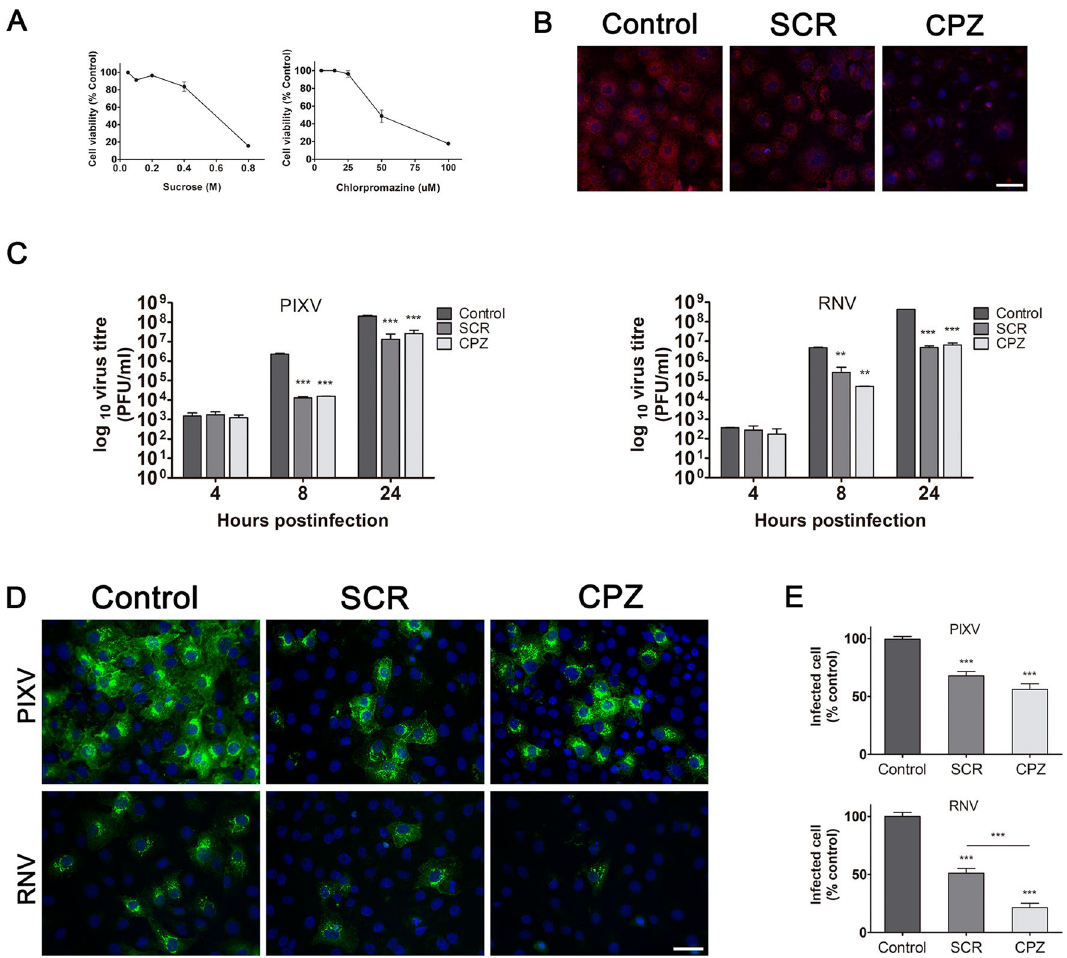
Figure 1. Assays with inhibitors targeting clathrin-mediated endocytosis of PIXV and RNV entry. ( A ) MTT assay to determine SCR and CPZ cytotoxic concentrations. ( B ) Representative images of Vero cells treated with 0.2 M SCR or 25 µM CPZ and incubated with TRITC-transferrin (red); nuclei (blue). ( C ) Cells were treated with 0.2 M SCR or 25 µM CPZ and infected with PIXV or RNV at MOI 0.1. Supernatants were collected at 4, 8 and 24 hpi and extracellular infectious particles were quantified by plaque assay (plaque-forming unit, PFU/ ml). ( D ) Representative images of cultures treated with 0.2 M SCR or 25 µM CPZ and infected with PIXV or RNV (green) at MOI 10 and fixed at 8 hpi; nuclei (blue). ( E ) Percentage of infected cells with PIXV or RNV against control (100% value). Data represent the mean ± SD from 3 independent experiments. Significance was calculated by one-way ANOVA test, followed by Tukey post-hoc analysis to enable specific group comparisons, with p value ≤ 0.05 considered as statistically significant. ** p < 0.01; *** p < 0.001. Scale bar: 20 ments and the viral proteins (PIXV: r = 0.68 ± 0.11 for Rab5 and r = 0.78 ± 0.06 for Rab7; RNV: r = 0.69 ± 0.1 for Rab5 and r = 0.75 ± 0.07 for Rab7) (Fig. 3B). These results show that PIXV and RNV associate to early and late endosomes at the early stage of the infectious cycle. To study the low pH-dependence of PIXV and RNV replication, we first evaluated the effect of two lysoso- motropic agents, GlcN and NH 4 Cl, inhibitors of endosomal vesicles acidification 10,26–33 , in Vero cells. Cell culture viability by MTT was assayed at different concentrations of either of these two inhibitors (Fig. 4A). Thus, we defined 15 mM GlcN and 25 mM NH 4 Cl as the experimental conditions (cell viability ≥ 90%). To assure the effect of both compounds in intracellular acidic vesicles, we pretreated Vero cells with the drugs plus acridine orange. Cultures treated with NH 4 Cl showed significant differences in the fluorescence intensity of the cells cytoplasm (56.3%; p < 0.001) compared to controls (100%). However, this effect was not observed in culture cells treated with GlcN, where acridine orange fluorescence inside the cell cytoplasm did not display significant differences (87.1%) compared to the control condition (Fig. 4B). We then performed the cytoplasmic accumulation assay with neutral red, a very sensitive probe for lysosomal microenvironments and a biological pH indicator 43 . In Fig. 4C, a 40% and 80% inhibition of the neutral red signal can be observed in cultures treated with GlcN and NH 4 Cl, respectively, compared to untreated cells. Therefore, the participation of endosomal pH in PIXV and RNV replication in Vero cells was analyzed by extracellular virus titration. Viral progeny production of PIXV and RNV was reduced by about 3 log 10 and 4 log 10 in cultures incubated with GlcN or NH 4 Cl respectively, at 8